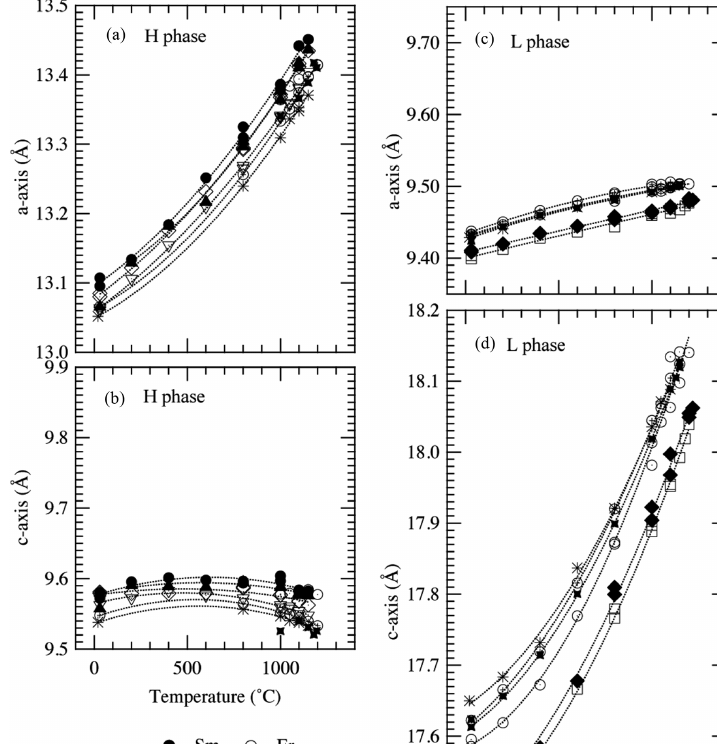
Figure 4: The unit cell parameters versus the sum of the effective ionic radius ratio, r R + r O , at room tem- perature; (a) a - and (b) c -axes of the H phase, and (c) a - and (d) c -axes of the L phase. Note that horizontal axes are